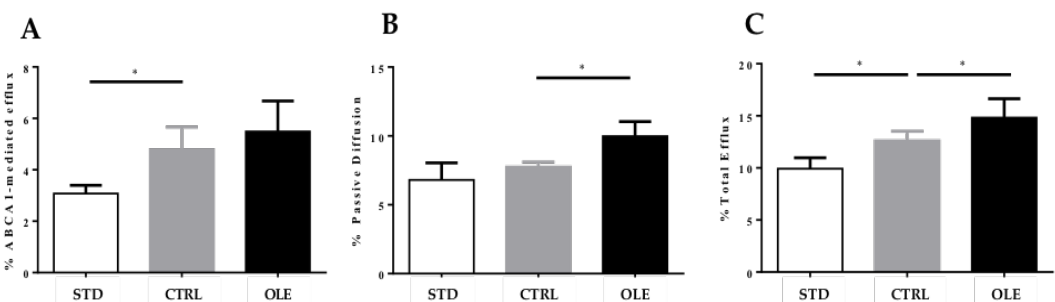
Figure 4. Cholesterol efflux capacity of hamster plasma: evaluation of cholesterol efflux from J774 macrophages incubated with hamster plasma treated with standard diet (STD group), or high-fat diet (CTRL group), or a high-fat diet and with Oleactiv ® (OLE group): % ABCA-1-mediated efflux ( A ), % passive diffusion ( B ) and % total efflux ( C ). The experiment was performed in triplicate. Efflux was expressed as counts per minute in medium/counts per minute of time 0 ×100 ± SD. Statistical analysis were performed using ANOVA one way, with Dunnett’s multiple comparison test. * = p < 0.05.